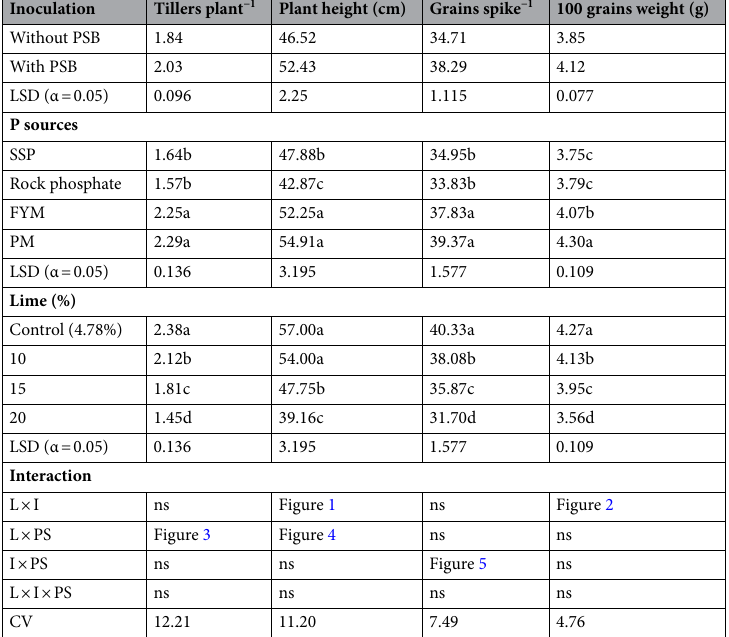
Table 3. Impact of PSB inoculation and P sources on wheat tillers per pot, plant height, grains per spike and 100 grains weight in soil with varying lime content. PSB, LSD, SSP, FYM, PM and ns denote phosphate solubilizing bacteria, least significant difference, single super phosphate, farmyard manure, poultry manure and non-significant interaction, respectively. Means sharing letter in each category are statistically at par at α ≤ 0.05.